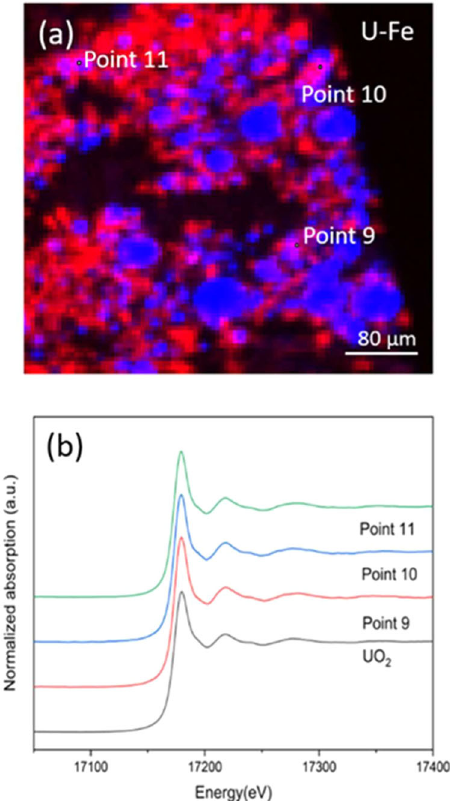
Fig. 9 µ-focus X-ray analysis of MCCI-3. Showing a the correlation map of the distribution of U-L α (red) and Fe-K α (blue); and b corresponding U L 3 edge μ -XANES spectra of points in a . Scale bar of a is 80